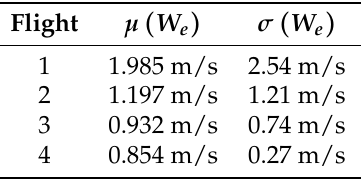
Table 9. Mean and standard deviation of difference between the wind speed estimations and the wind speed